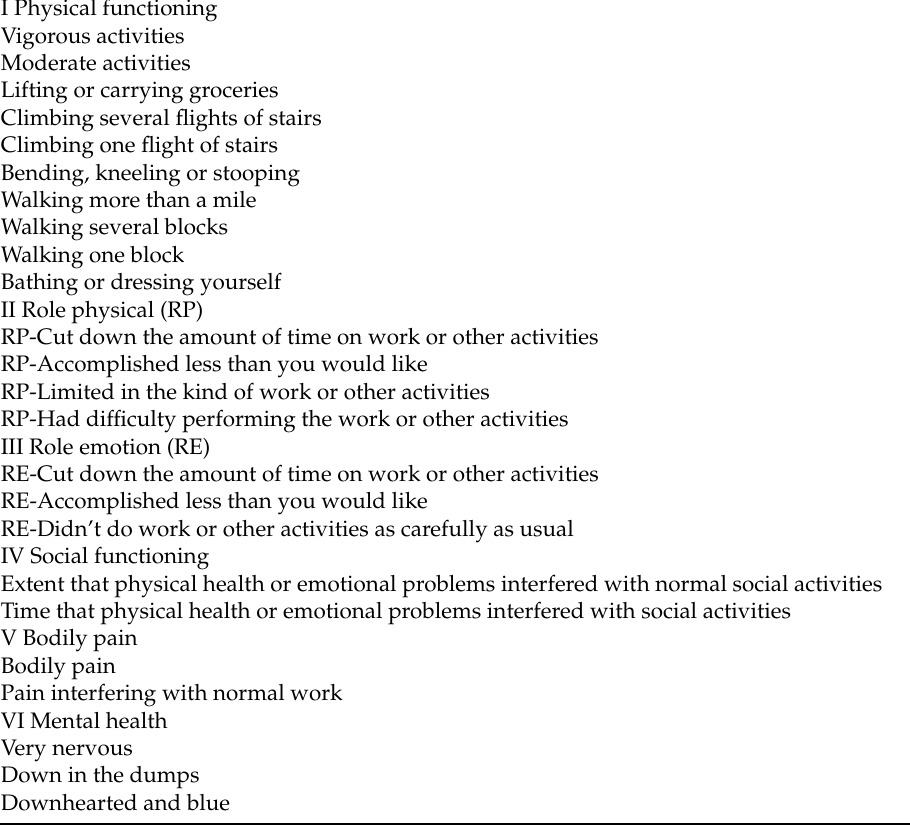
Table A1. Generic factor structure of the SF-36 assessment for a normal